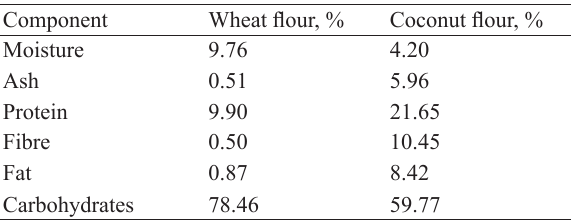
Table 1 Comparative proximate composition of wheat flour and coconut